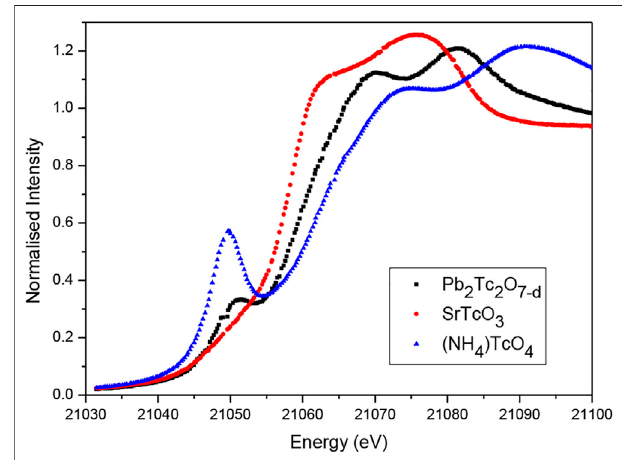
FIGURE 4 | Normalised X-ray absorption spectra of Pb 2 Tc 2 O 7-d , SrTc 4+ O 4 and (NH 4 )Tc 7+ O 4 . The Tc has six-fold coordination in Pb 2 Tc 2 O 7-d and SrTcO 3 and is in a tetrahedral environment in (NH 4 )TcO 4